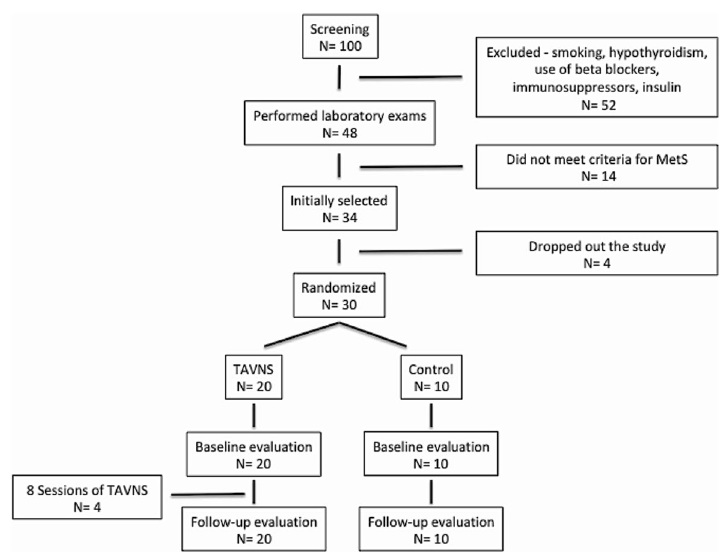
Fig. 2 Flow chart of the